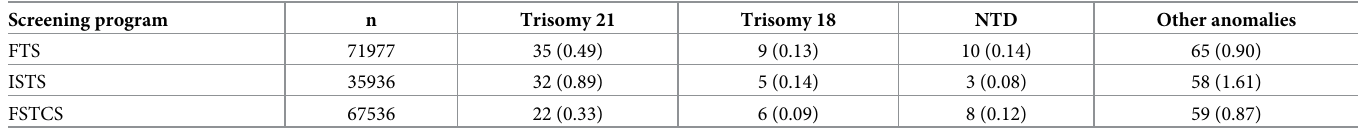
Table 3. Confirmed sample distribution and incidence statistics n